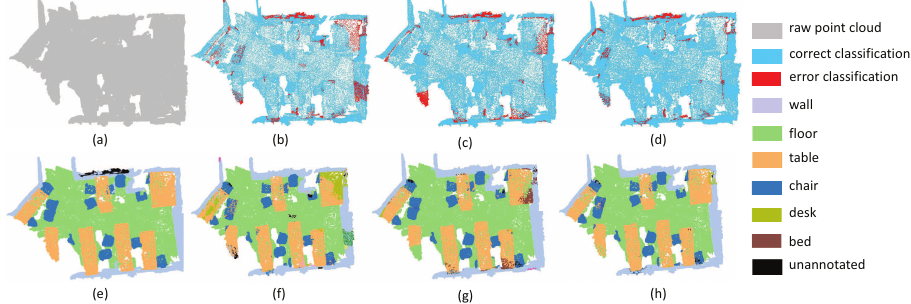
Figure 9. The edge segmentation results on Restaurant . ( a ) input, ( e ) ground truth, ( b , f ) the classification result by PointNet++, ( c , g ) the classification result by PointSIFT, and ( d , h ) the classification result by SAN.